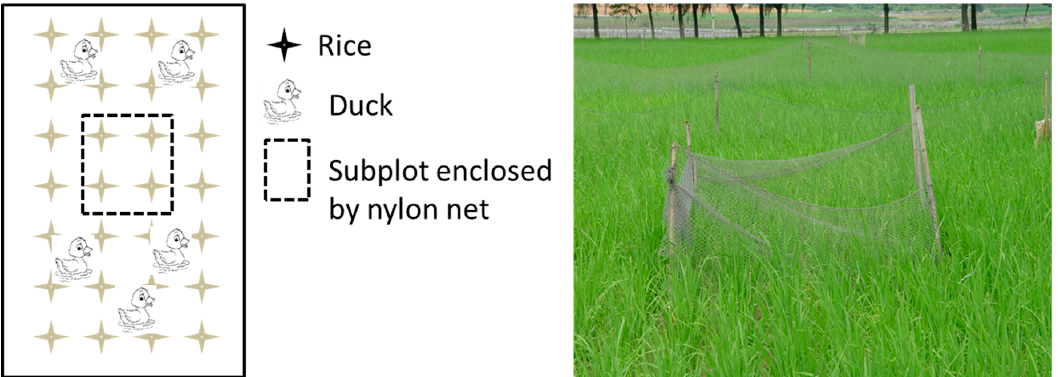
Figure 2. The scheme and a photo of turbid water treatment conducted in this study. Ducks could not move into the subplot enclosed by nylon net to trample and forage, but the muddying water could exchange in and out of the subplot due to the movements of ducks around the subplot.